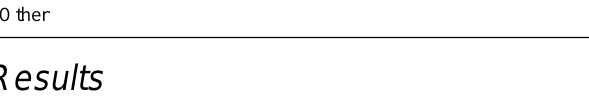
n or meanCharacteris-